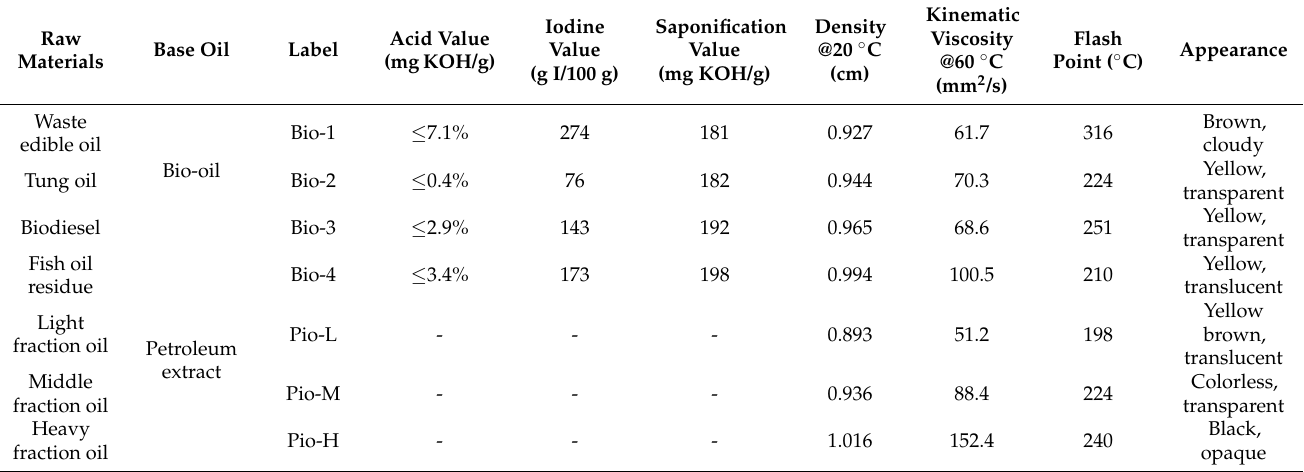
Table 2. Properties of the seven